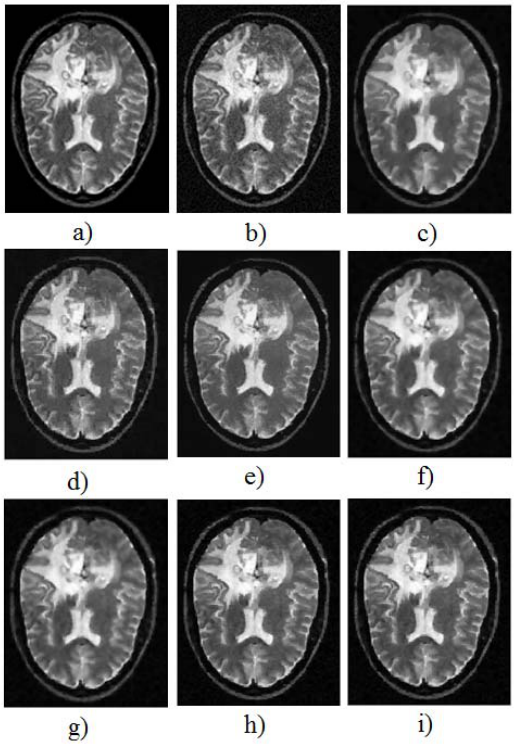
. On figure 2 show example results of